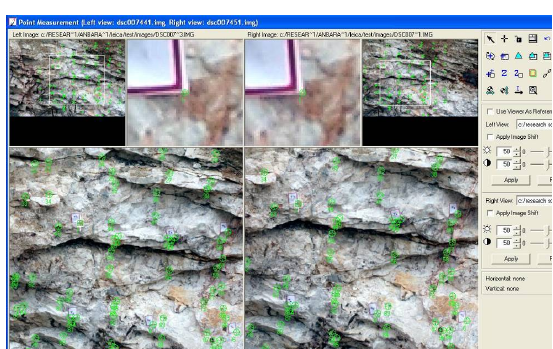
Figure 5: Point Measurement (GCP, Tie points, Check